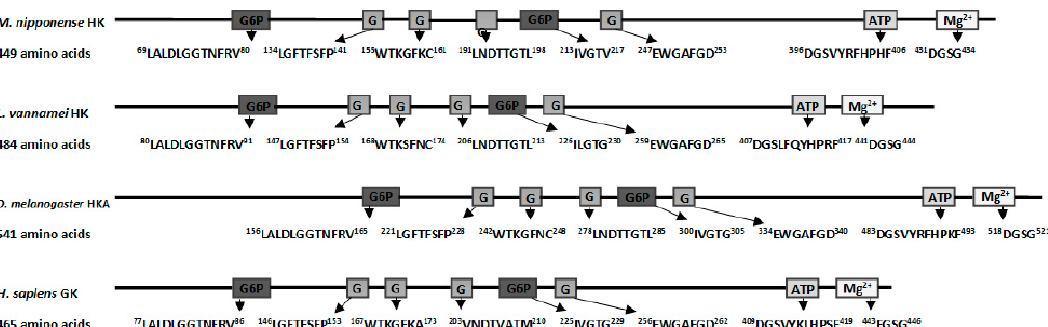
Figure 2. Graphical representation of hexokinase (HK) domains from Macrobrachium nipponense (HK, KY270495), Litopenaeus vannamei (HK, ABO21409), Drosophila melanogaster (HKA-A, NP_524848), and Homo sapiens (GK 1, AAB97682). The amino acids implicated in glucose (G), glucose-6-phosphate (G6P), ATP, and Mg2+ binding sites are indicated in boxes.